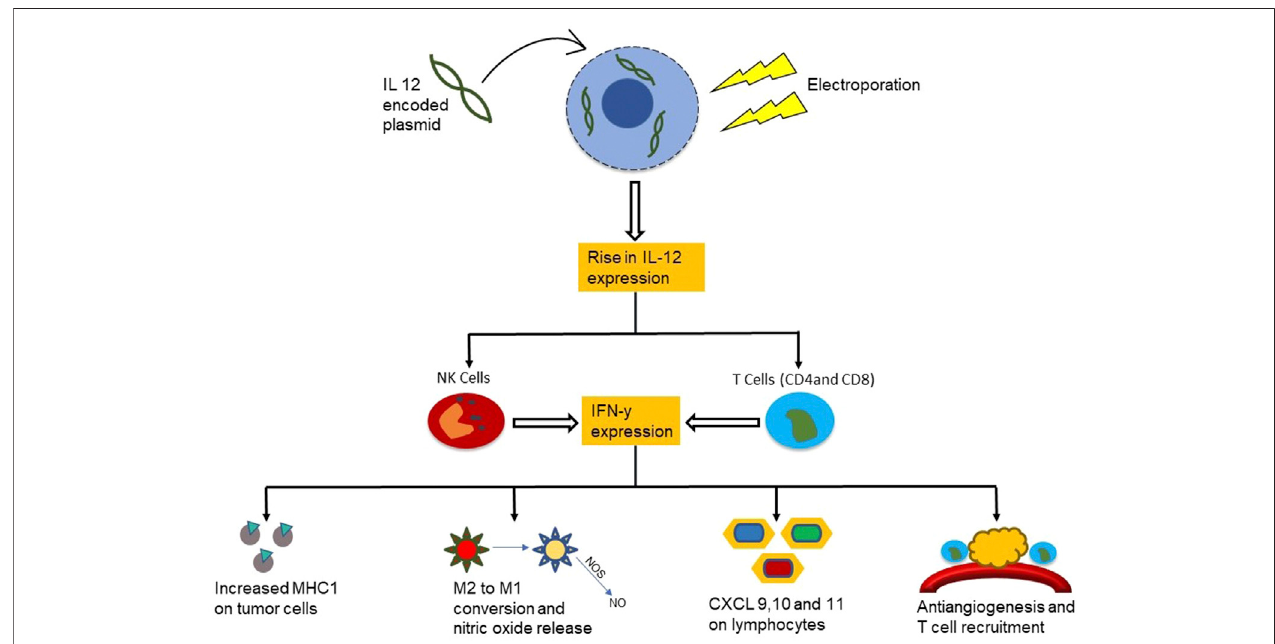
FIGURE4| MechanismofthefunctioningofcytokineIL-12incombinationwithelectroporationincancertreatment.TheIL-12plasmiduptakeintothecancercellis higher after electroporation which upregulates the IL-12 release near the tumor. This attracts NK cells and T cells to the cancerous region leading to increased IFN-y expression and a cascade of anti-cancer immune